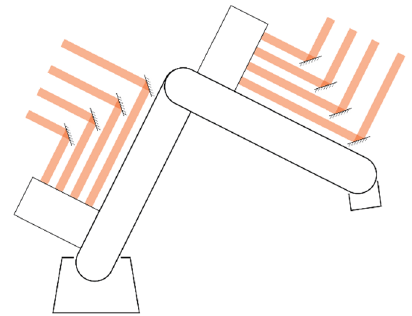
Figure 2. The principle of operation of a robot proximity monitoring system based on one centralized ranging device per robot’s segment and individual fields of view redirected by mirrors. The robot segment lengths are usually from 0.2 m to 0.8 m, and the detection range from the robot’s segment to the potential obstacle should be in compliance with the SSM mode of operation, as specified in ISO/TS 15066:2016. In a real application, the field of view redirection optics would be located as close to the robot’s surface as